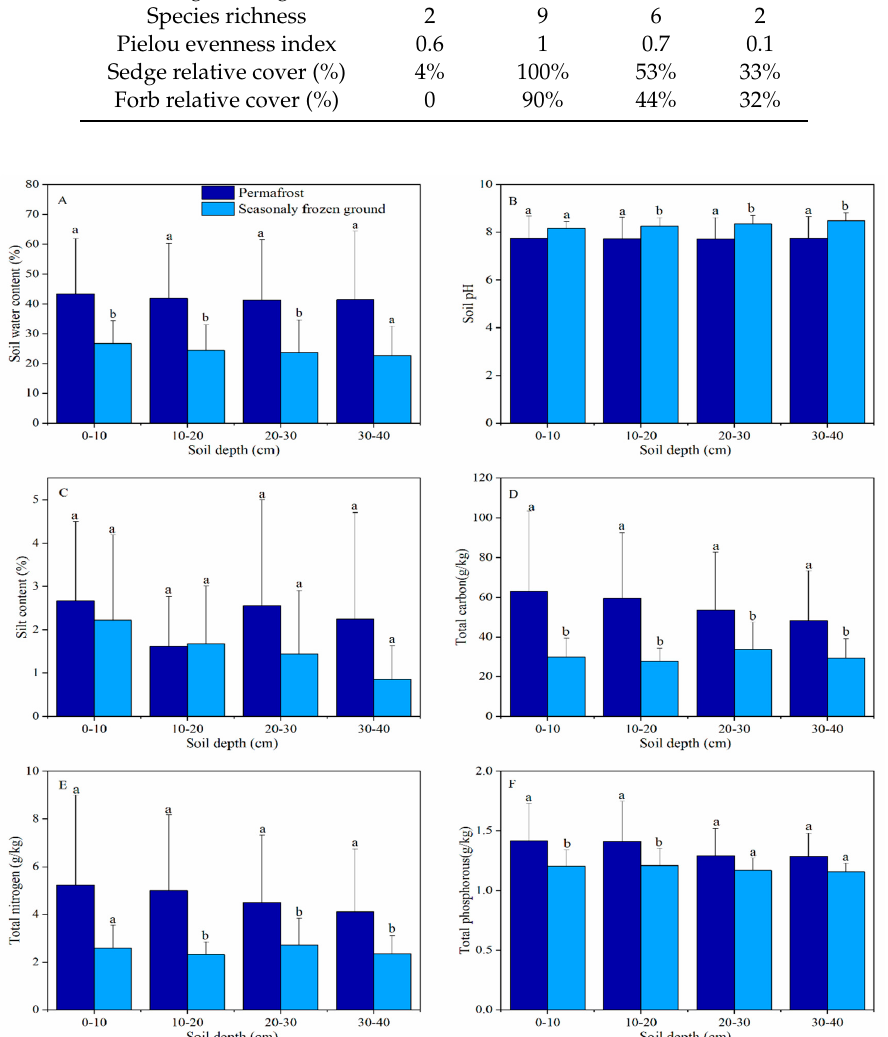
Figure 2. Soil physical properties and nutrient content in permafrost and seasonally frozen ground.